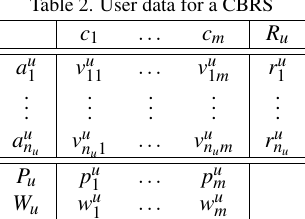
Table 2. User data for a